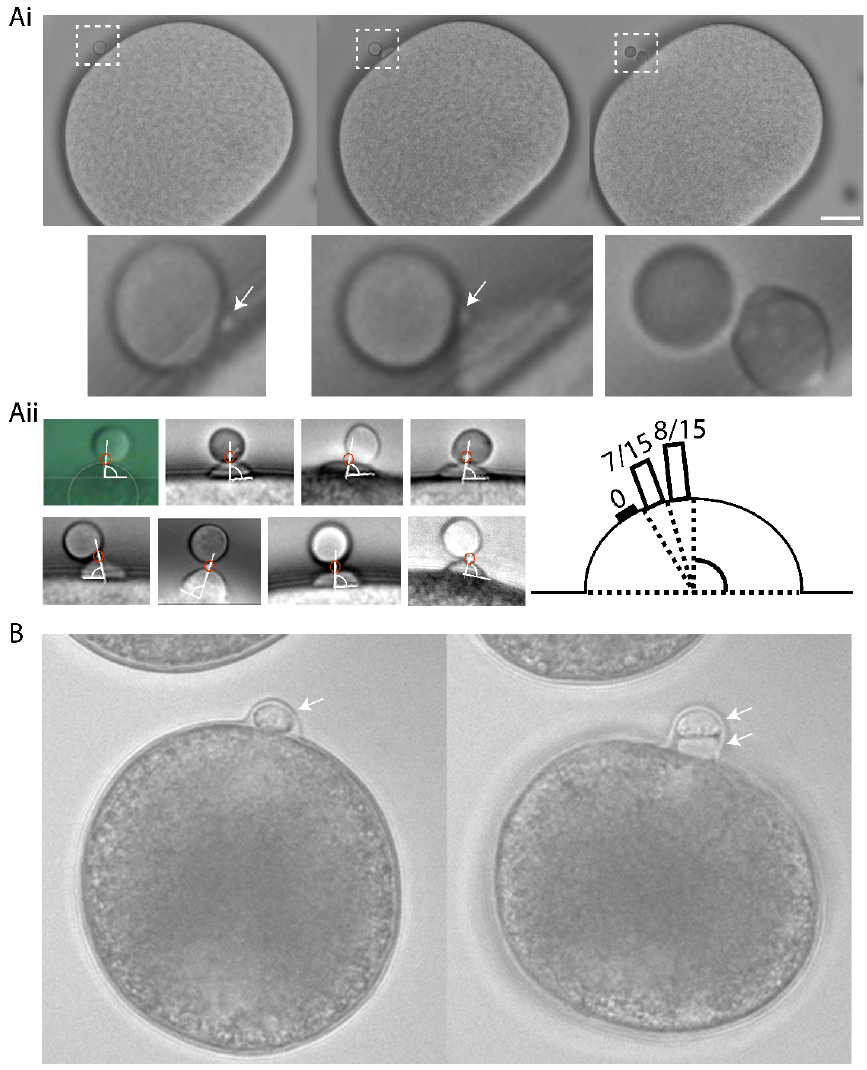
Figure 1. A small protrusion forms on the surface of the PB2 outpocket in Phallusia . ( Ai ) Bright field images from a time-lapse experiment of fertilized Phallusia mammillata eggs. During polar body 2 (PB2) emission, a small polar corps can be observed on the surface of PB2 outpocket (boxed region). Enlarged views of the boxed regions at the bottom show in greater detail the small protrusion which is present before outpocketing begins (bottom left, arrow) and remains present during outpocketing (bottom middle, arrow). n > 50 eggs. Scale bar = 20 µ m. See Supplementary Movie S1. ( Aii ) Analysis of angle between polar corps (red circle) and outpocket center. Diagram illustrating a summary of the polar corps position at 61–70 ◦ , 71–80 ◦ and 81–90 ◦ (number of eggs in brackets). Mean polar corps position was 81.4 ◦ +/ − 1.4 ◦ +/ − sem, n = 15. ( B ) Bright field images from a time-lapse experiment showing PB2 emission under PB1 in Mytilus galloprovincialis. PB1 is indicated by the arrow in the first image, and both PB1 and PB2 by the two arrows in the second image. n = 50 / 50. See Supplementary Movie